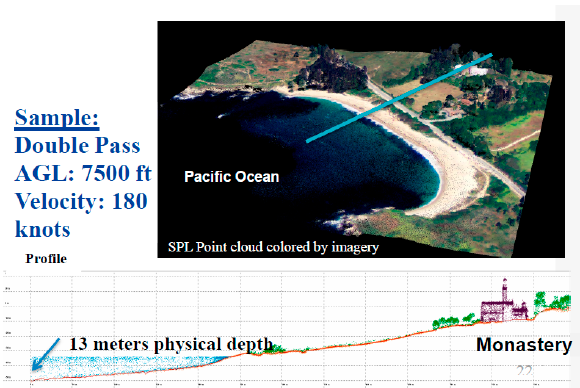
Figure 13. Top : Colored HRQLS-1 lidar topo-bathymetric 3D pointcloud of a hilltop monastery and the beach at Pt. Lobos near Monterey, CA; Bottom : The bottom image shows the 2D lidar profile along the blue line in the top figure and extending from the monastery to the beach and into the Pacific Ocean to an optical depth of 17.3 m or a physical depth of 13 m. Vertical grid size = 10 m, Horizontal grid size = 50 m.